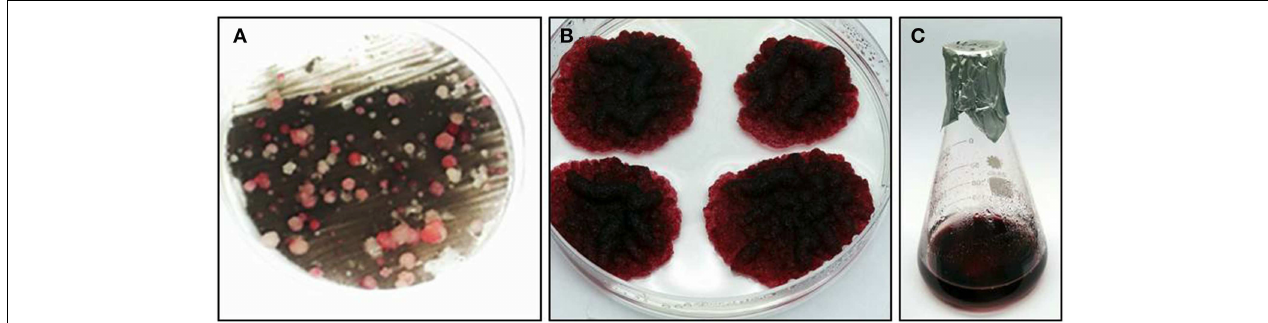
FIGURE 1 | Transformation of transgenic Vitis vinifera cv. Gamay cell culture. (A) kanamycin resistant cell culture colonies, from which the four AroG * lines were chosen. (B) Typical AroG * cell culture colonies, (C) Growth of the culture in liquid medium.